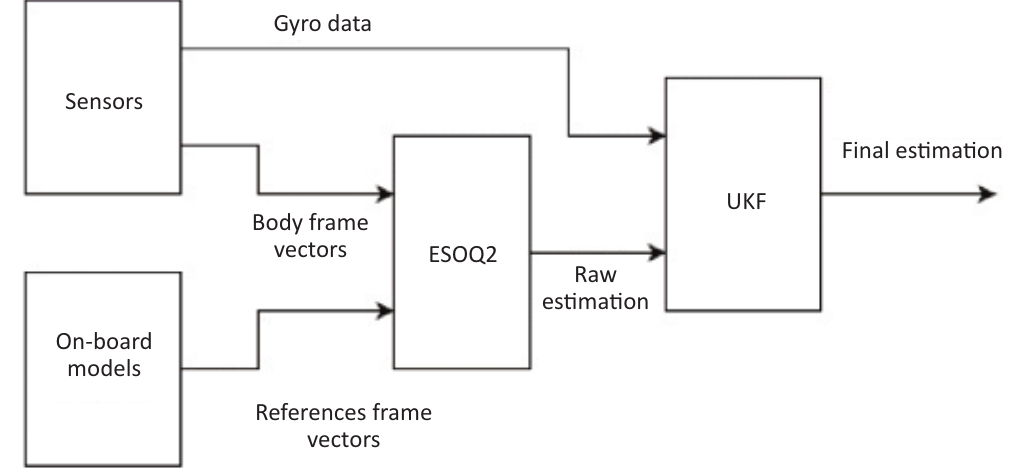
Fig. 6. Attitude determination